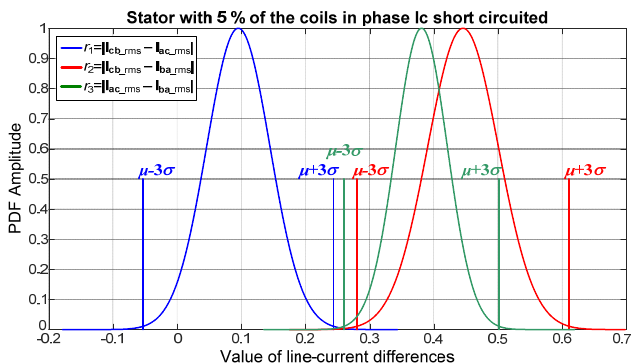
Figure 14. PDF for the arithmetic differences r 1 , r 2 , and r 3 from a motor with 5% of the coils in its phase I c winding short-circuited.